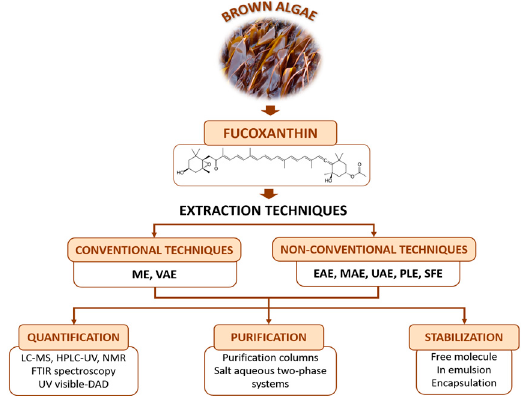
Figure 1. General overview of the sources of fucoxanthin, extraction and quantification / identification techniques, purification systems and stabilization studies for further industrial application of this compound. The definition for the abbreviations used in this figure can be seen in the abbreviation list provided. Extraction methods and conditions: Maceration extraction (ME); Vortex-assisted solid-liquid micro-extraction (VAE); Enzyme assisted extraction (EAE); Microwave-assisted extraction (MAE); Ultrasound-assisted extraction (UAE); Pressurized liquid extraction (PLE); Supercritical fluid extraction (SFE). Detection method: High Performance Liquid Chromatography (HPLC); HPLC with diode array detector (HPLC-DAD); HPLC with ultraviolet detector (HPLC-UV); Liquid Chromatography-Mass Spectrometry (LC-MS); Nuclear Magnetic Resonance ( 1 H-NMR); Fourier Transform-Infrared Spectroscopy (FTIR).